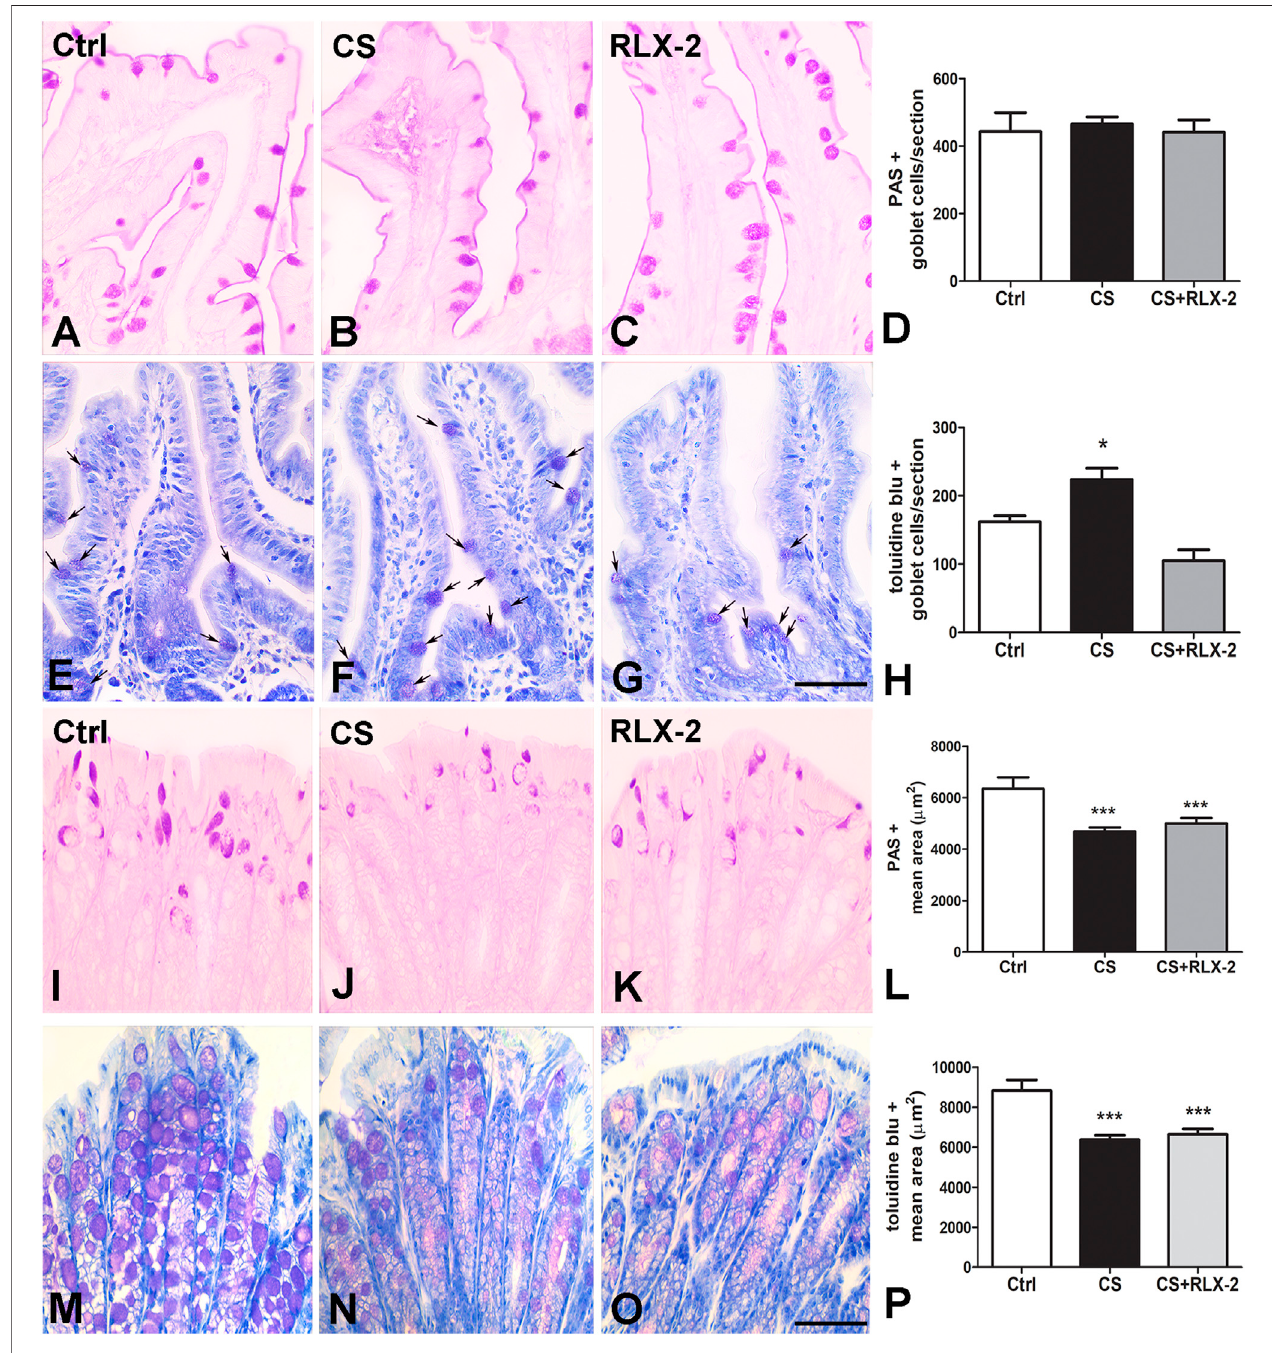
FIGURE3| Periodicacid – Schiff(PAS)reactionandToluidineblue(TB)stainingandmucinchangesinthecigarettesmoke(CS)group. (A – H) Ileum.Representative images of the mucosa stained with PAS (A – C) and TB (E – G) . Both dyes stained the goblet cells. Quantitation of the stained cells showed no differences among the groupsofanimalsusing thePASreaction (D) ,whereasasigni fi cantincreaseinthenumberofgobletcellsstainedwithTBwasdetectedinCS-exposedanimals (H) .This increase was prevented by relaxin-2 (RLX-2) treatment (H) . (I – P) Colon. Representative images of the mucosa stained with PAS (I – K) and TB (M – O) . Quantitation of the stained areas, with each dye showing a signi fi cant decrease in CS-exposed animals (L , P) . RLX-2 did not prevent the decreases (L , P) . Bar , 50 μ m (A – C , E – G , I – K , M – O) . * p < 0.05; *** p < 0.0001.